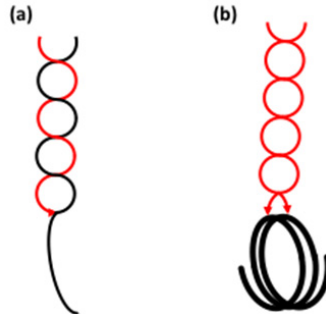
Figure 5. Detail of the backbone model suggesting the formation of double-helices. ( a ) A-B double-helix in an external building block formed by an A-chain ( red ) and the external segment of a B-chain ( black ). ( b ) A-A double helix formed by two A-chains connected to a helical backbone (bold black line). Arrows symbolise